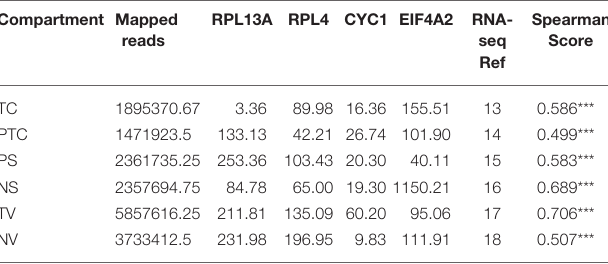
TABLE 3 | Transcription data results and Spearman correlation score. Compartment Mapped reads